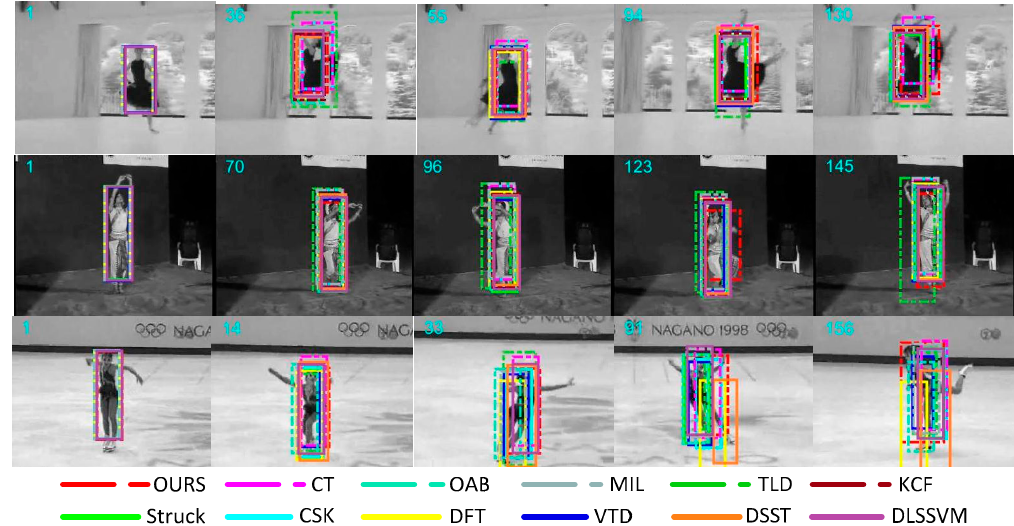
Figure 2. Tracking results of the proposed method and eleven state-of-the-art tracking methods on sequences Dancer , Dancer2 , and Skater . In these sequences, there is a non-rigid deformation problem.